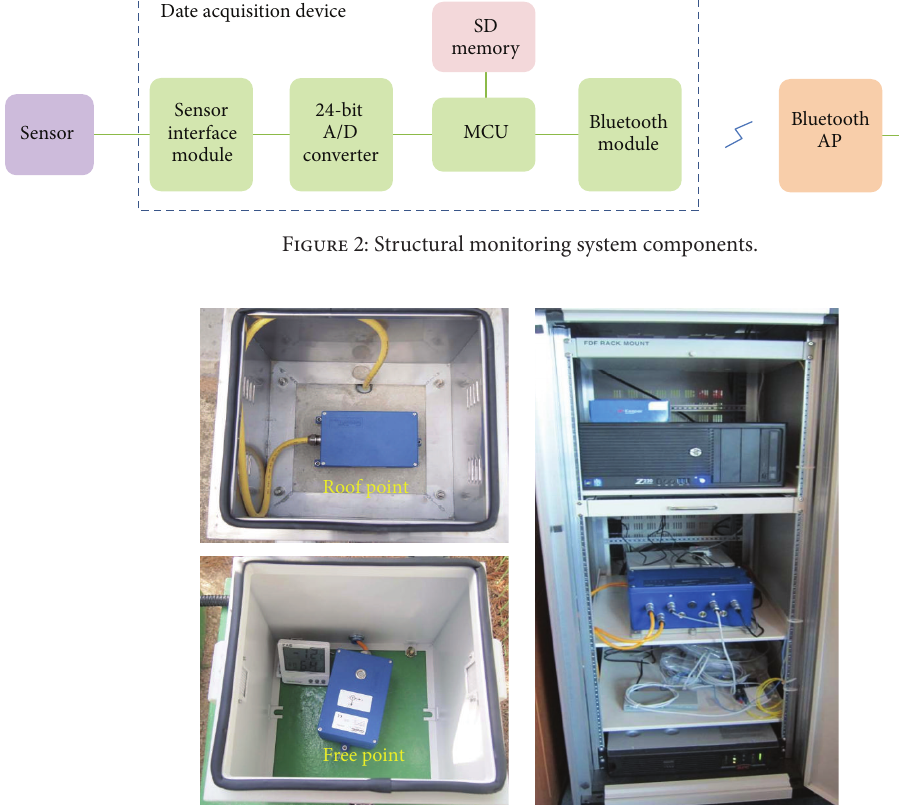
Figure 1: Administration building.